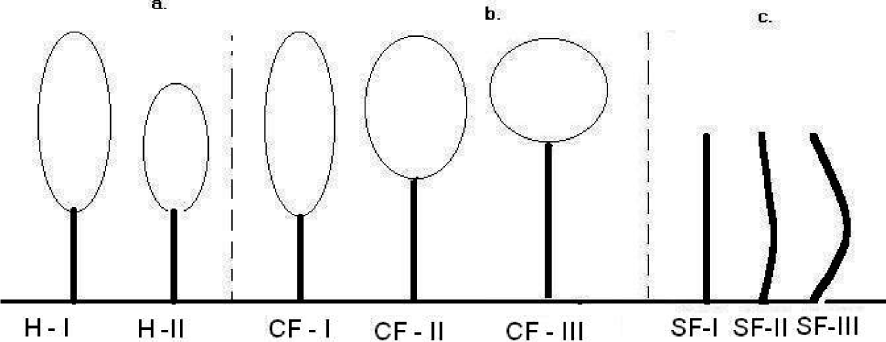
Figure 3. Classification of trees into (a) height, (b) crown form and (c) stem form